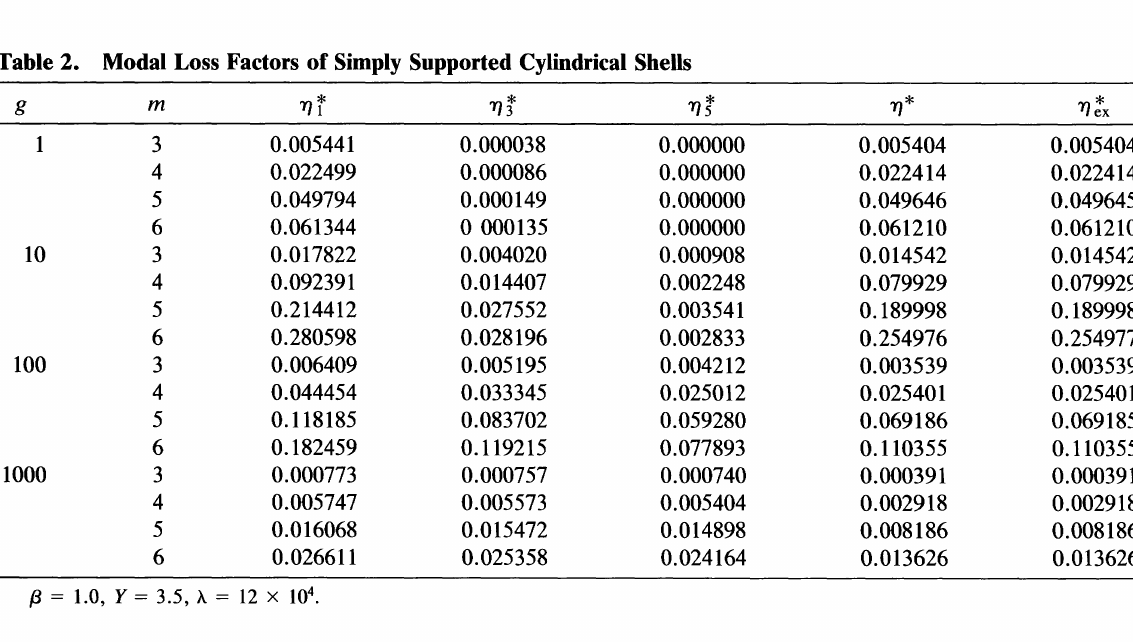
Table 2. Modal Loss Factors of Simply Supported Cylindrical Shells